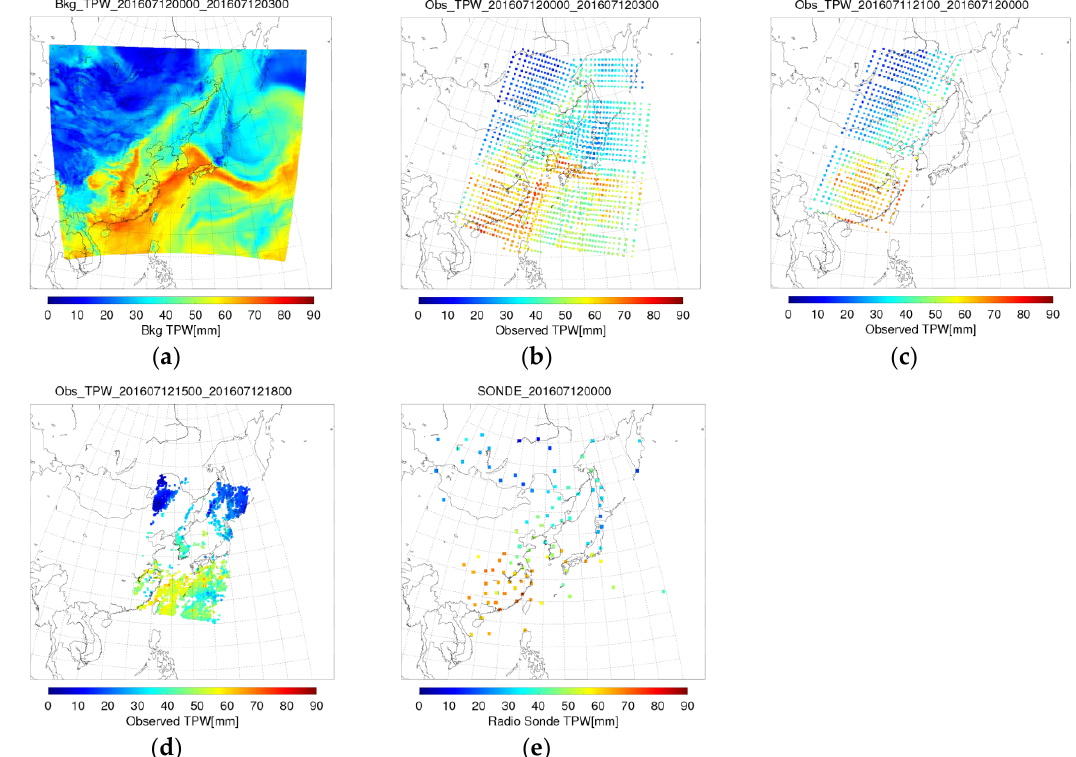
Figure 2. Datasets. ( a ) Background data comprised of UM forecast TPW; ( b ) MetOp-A,B (ATOVS) retrieved TPW data; ( c ) NOAA-18 (ATOVS) retrieved TPW data; ( d ) Suomi-NPP (CrIS) retrieved TPW data; and ( e ) Radiosonde data for the validation. The time periods for the NOAA-18 and Suomi-NPP data are different because there is no NOAA-18 and Suomi-NPP data for the time period used in ( a , b